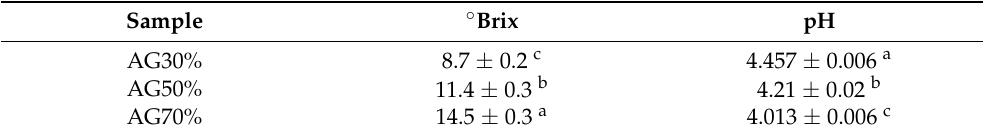
Table 1. Mean values (and standard deviations) of °Brix and pH of apricot gel. Sample